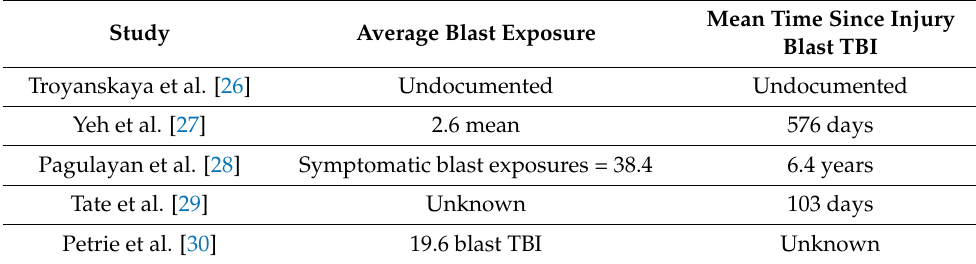
Table 2. Summary of blast exposure information.